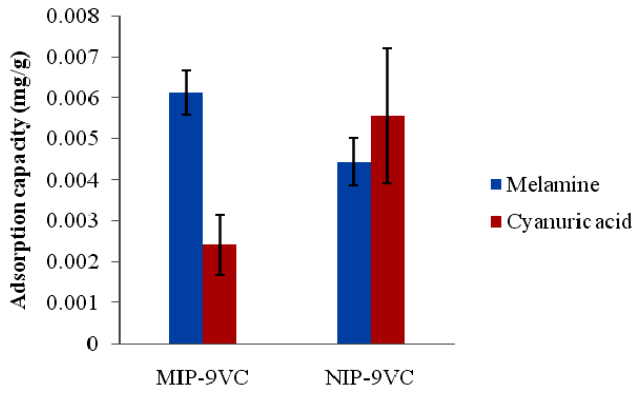
Figure 11. Selectivity study of melamine by MEL-MIP-9VC and NIP-9VC in the presence of cyanuric acid. The solution (10 mL) containing cyanuric acid (10.0 ppm)